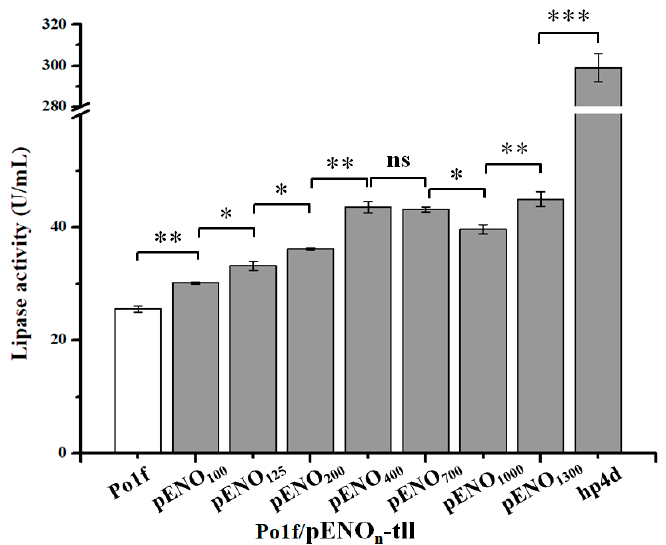
Figure 2. TLL activity of recombinant strains Po1f/pENO n -tll harboring different truncated enolase promoter pENO n (n = 100, 125, 200, 400, 700, 1000, and 1300 bp). Statistical significance was calculated by unpaired T-test analysis. ns: no significant difference; *: p < 0.05; **: p < 0.01; ***: p < 0.001.